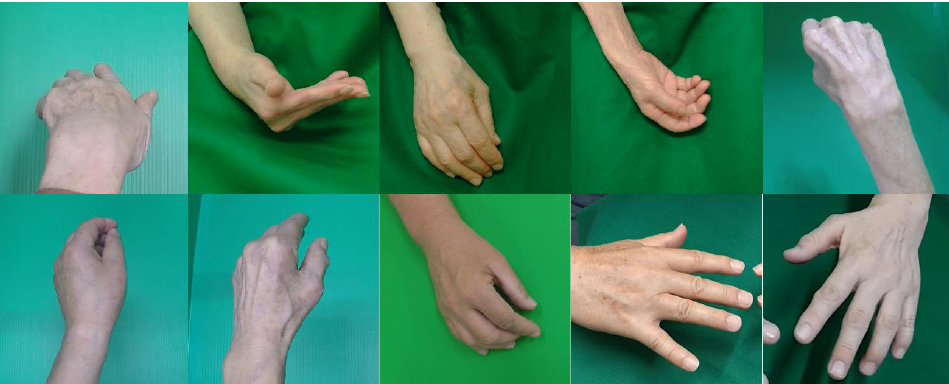
Figure 2. Image sequence example for each input video (10 videos).